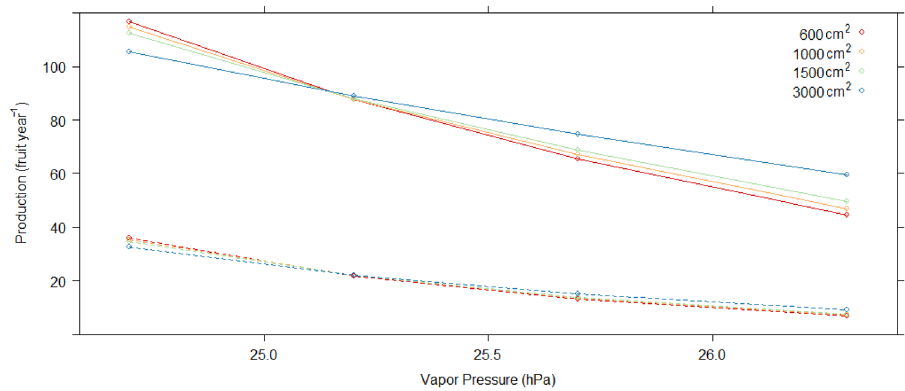
Figure 4. Model 2 marginal mean values of annual fruit production by vapor pressure (hPa) during dry season through flowering (DTF) at four values of sapwood area (cm 2 ). Solid lines = Cachoeira, dashed lines = Filipinas.